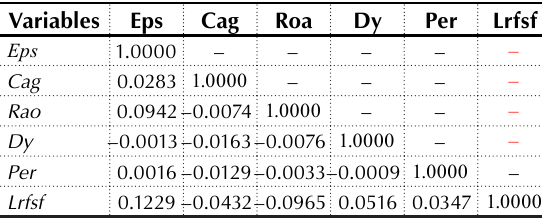
Table 6. Variance Inflation Factor (Value Stock